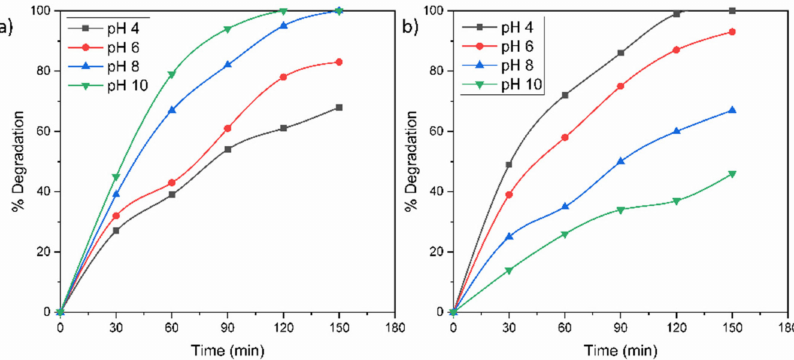
Figure 9. Effect of solution pH on the photocatalytic degradation of ( a ) RhB and ( b ) MO